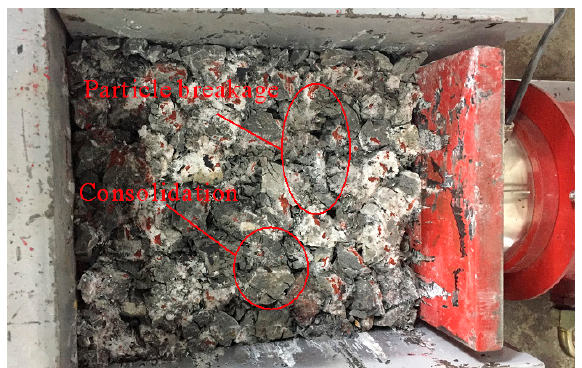
Figure 7. Particles of samples after compaction.